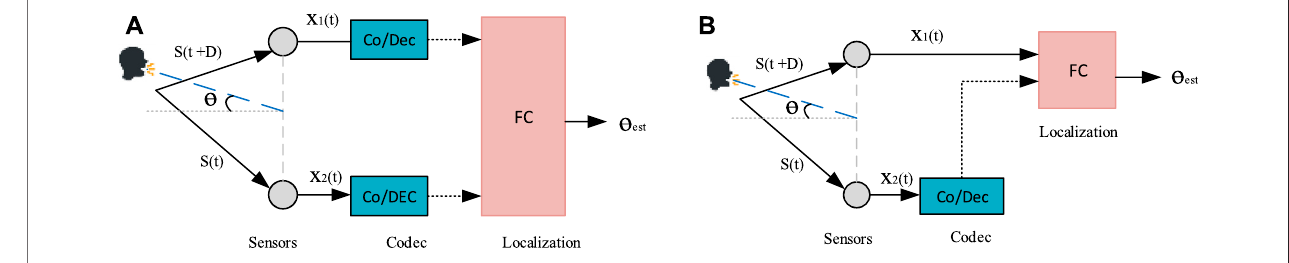
FIGURE1| Genericsystemmodels: (A) Twoencoded-channelmodel: Thetwodevicesjustrecords thesignalandsendstheencodedsignaltotheFC. (B) :Single encoded-channel model: One of the recording device itself is the FC.